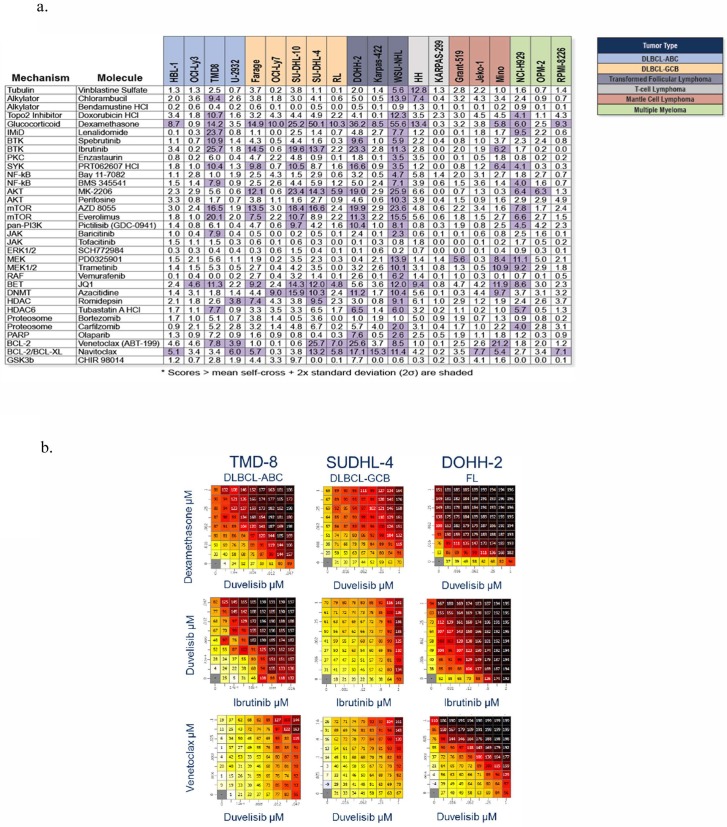
A. Synergy scores for combination of duvelisib with drugs with different mechanisms of action. Synergy Scores that exceed the mean self-cross plus two times the standard deviation are highlighted in purple. B. Synergy score heat maps for duvelisib combined with dexamethasone, ibrutinib and venetoclax. Representative heat maps for indicated combinations in the TMD-8, SUDHL-4 and DOHH2 cell lines. Scores up to 100 indicate growth inhibition while values >100 indicate cell death.